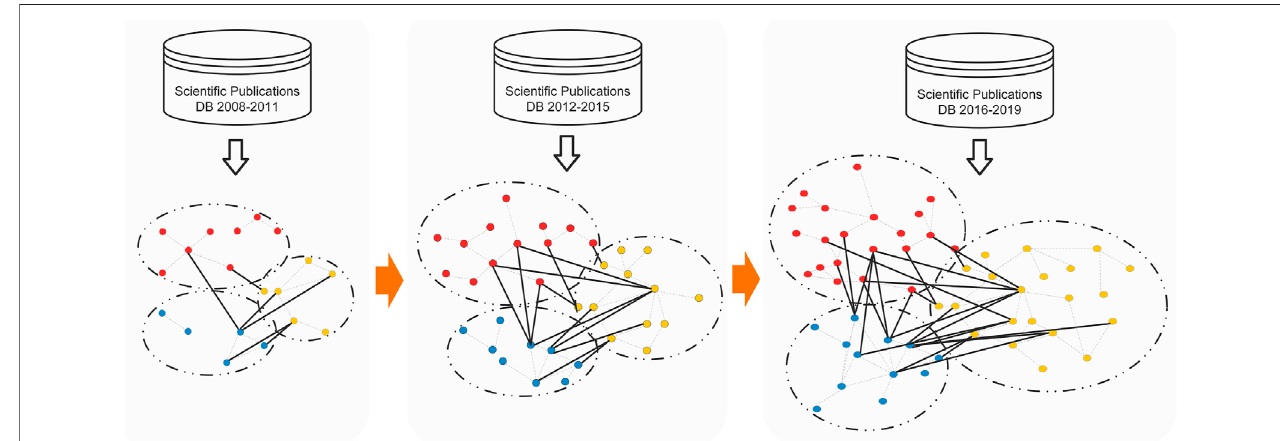
FIGURE 3 | Evolution of the technological components and their relationships.